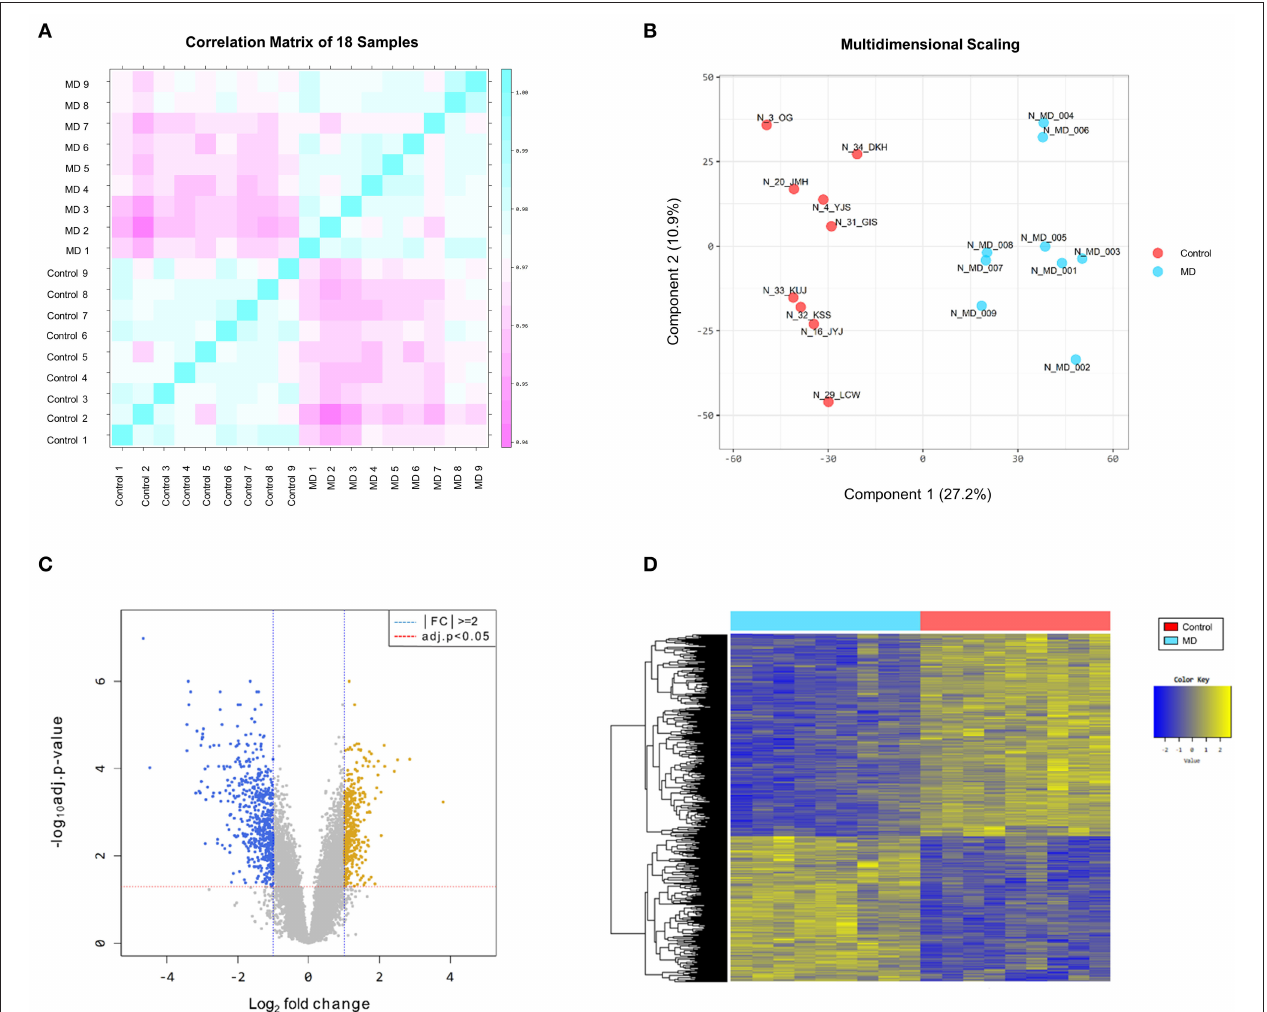
FIGURE 1 | (A) Pearson’s correlation analysis of samples. The color reflects the intensity of the correlation. The closer the correlation coefficient is to 1, the more it represents the blue color. There are strong correlations among the samples in the Meniere’s disease (MD) and control groups. (B) Multidimensional scaling of samples. There is a great difference in gene expression patterns between the MD (blue color) and control (red color) groups. (C) The volcano plot of differentially expressed genes (DEGs). Based on the cut-off criteria (|fold changes| > 2.0 and adjusted p -value < 0.05), 996 DEGs are identified between the MD and control samples, comprising 415 upregulated (yellow dots) and 581 downregulated (blue dots) in the MD group. (D) The results of a hierarchical clustering analysis of upregulated and downregulated DEGs between the MD and control groups. Each group includes nine individuals and each column represents one individual’s sample. The yellow and blue colors indicate high and low relative expression levels,